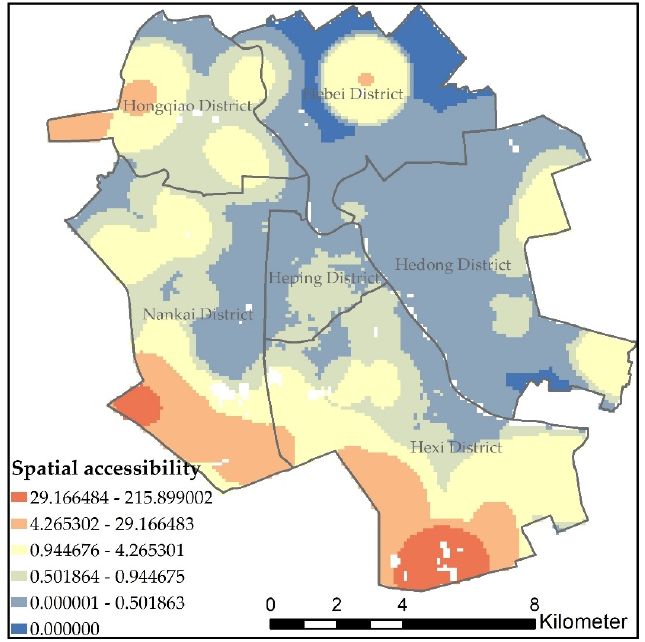
Figure 7. Spatial accessibility distribution calculated by A-2SFCA method.